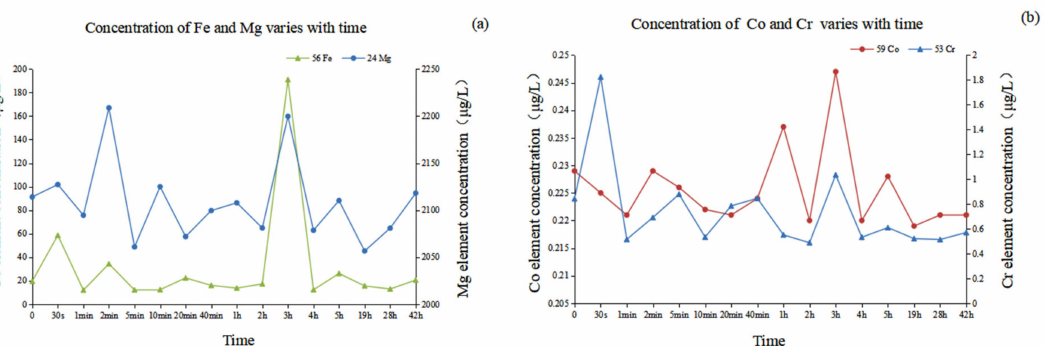
Figure 5. In UF water the effects of suspended particulate matter in different time adsorption and release of Fe and Mg ( a ); Cr and Co ( b